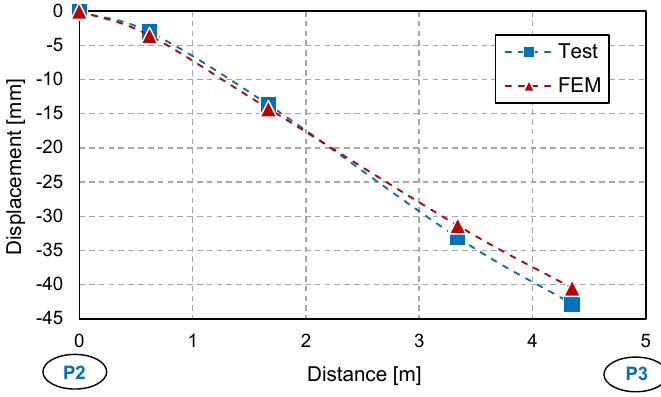
Figure 3. Comparison of the residual vertical deformed shape of the first floor between P2 and P3 in the experimental test [28] and FE model.